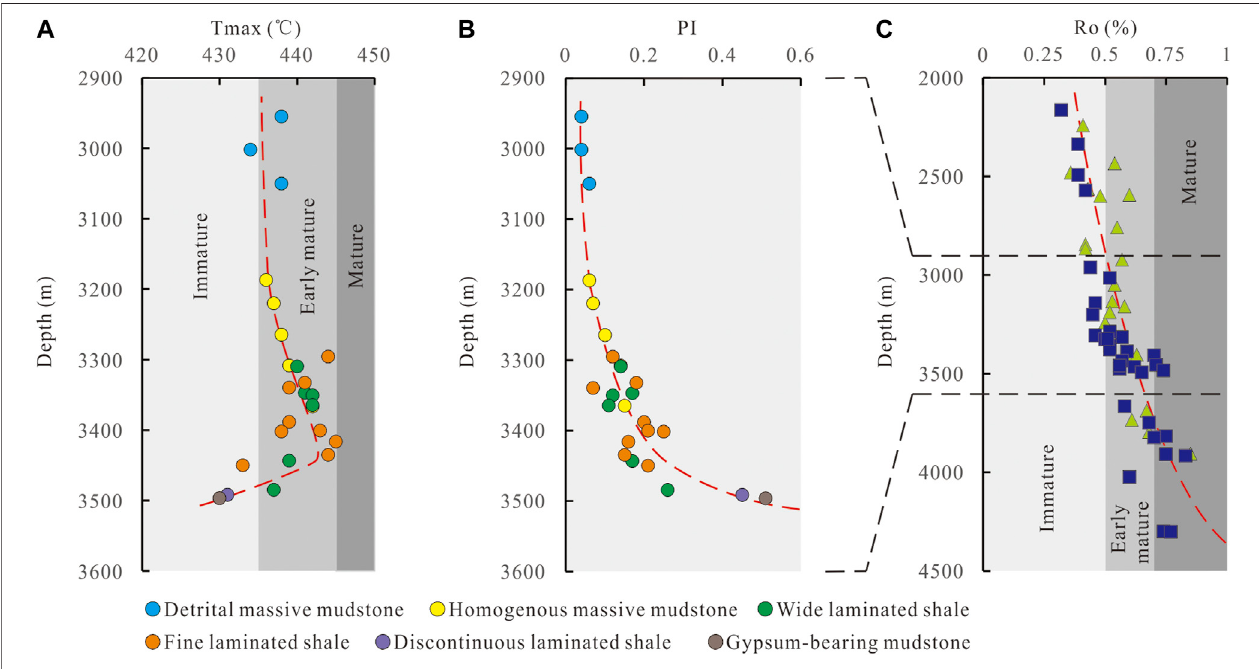
FIGURE 6 | T max , PI and R o versus depth pro fi les. (A) T max -depth. T max values slightly increased with increasing depth above 3,450 m, but beneath 3,450 m, the T max trend reversed, indicating suppression of T max . (B) PI (cid:1) S 1 /(S 1 +S 2 ) versusdepth plot. Samples with higher PIvalues usually showed lower T max values (Wang et al., 2015). (C) R